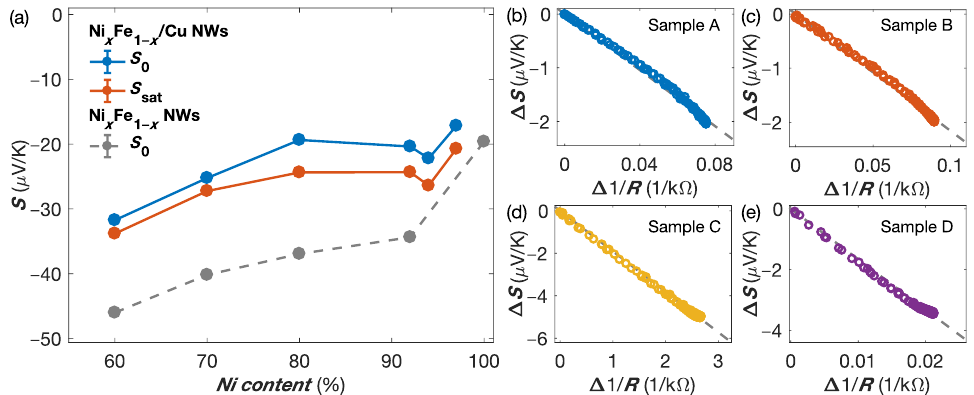
Figure 3. ( a ) Room-temperature Seebeck coefficients at zero magnetic field S 0 (in blue) and at satura- tion S sat (in red) as a function of the Ni content for various Ni x Fe 1 − x /Cu NW networks. The results previously obtained [20] on homogeneous Ni x Fe 1 − x NW networks are also shown for comparison (in grey). ( b – e ) Linear variation of ∆ S ( H ) = S ( H ) − S 0 vs. ∆ ( 1/ R ( H )) = 1/ R ( H ) − 1/ R 0 , illustrating the Gorter–Nordheim characteristics for ( b ) Ni 60 Fe 40 /Cu (Sample A), ( c ) Ni 70 Fe 30 /Cu (Sample B), ( d ) Ni 80 Fe 20 /Cu (Sample C), and ( e ) Ni 97 Fe 3 /Cu (Sample D) NW networks. The dashed grey lines in ( b – e ) shows the theoretical linear relation given in Equation